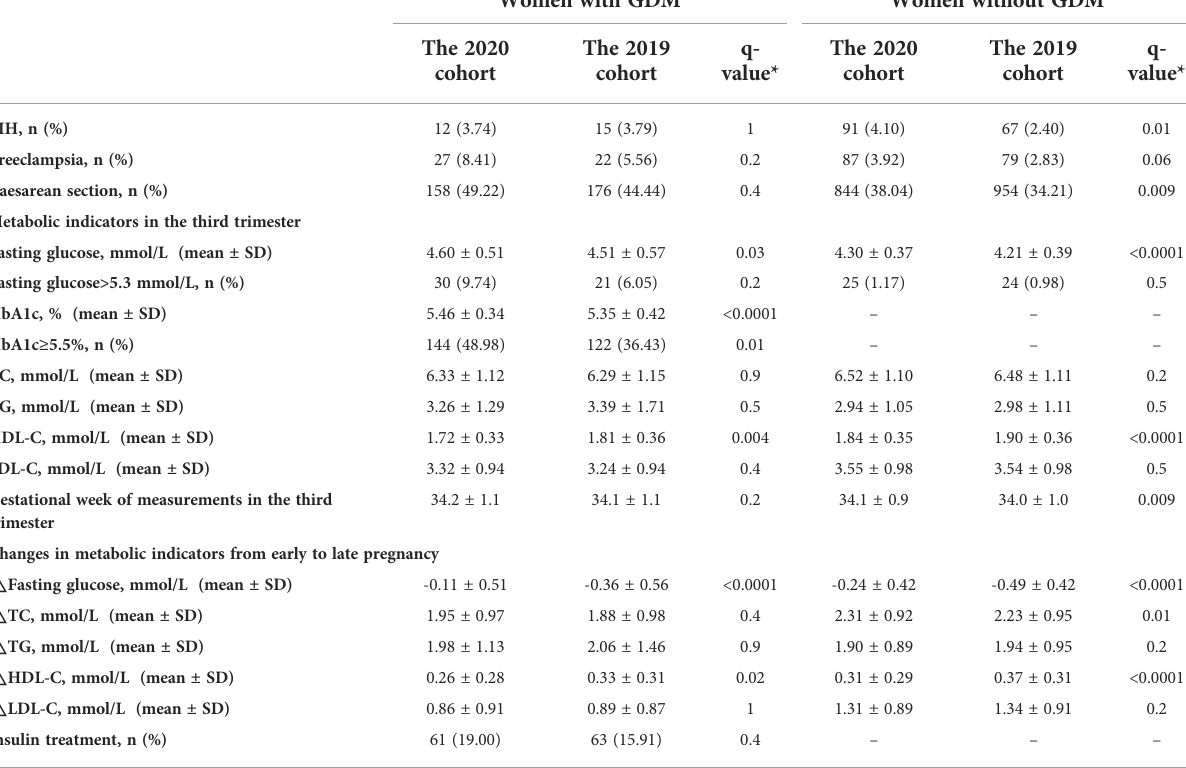
TABLE 3 Comparison of maternal outcomes between 2019 and 2020